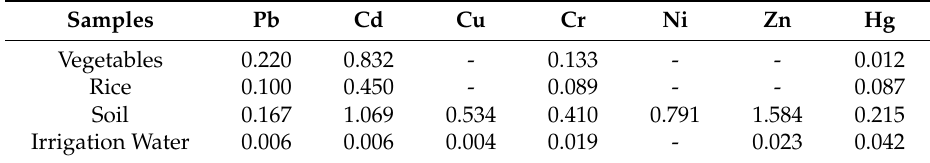
Table 6. Descriptive statistics of PIs metal concentrations in food and the environment.